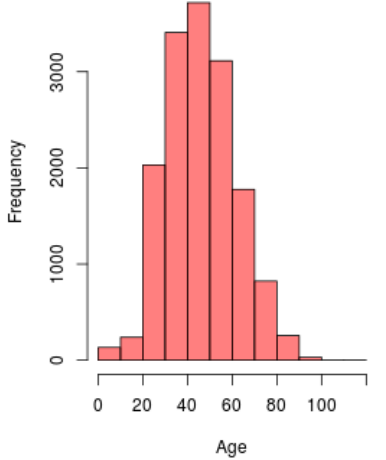
Figure 4. Histogram of the distribution by age the population from all the territory with positive SARS-CoV-2.